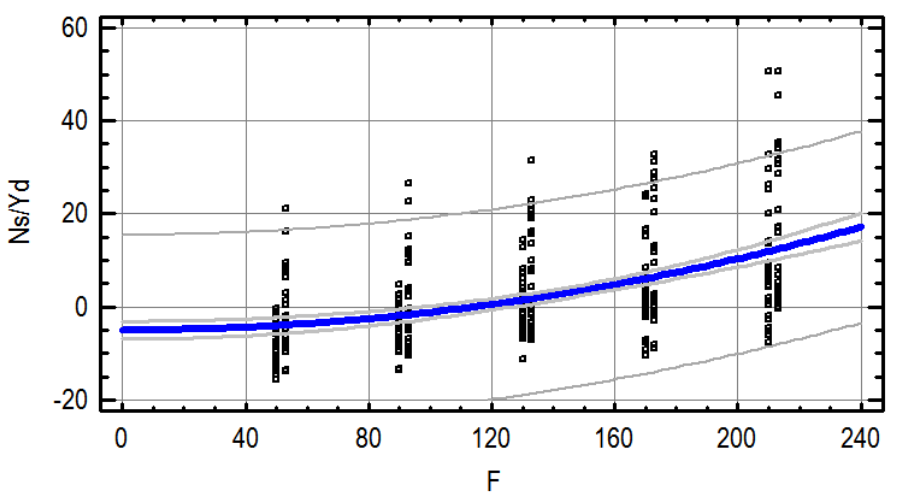
Figure 5. Observed and predicted yield-scaled N surplus (Ns/Yd, kg N·Mg − 1 ) depending on nitrogen doses (F, kg N·ha − 1 ) (R 2 = 23.9%, n = 320) . The relationship between N 2 O/Yd and N doses was described by the reciprocal-Y model: N 2 O/Yd = 1/(4.88 − 0.0138*F), R 2 = 47.0% (Figure 6). The estimated N 2 O/Yd values for the critical doses of F 112 and 149 kg N · ha − 1 were 0.30 and 0.35 kg N · ha − 1 , respectively. The curve increases steeply at higher N doses. At these doses, the spread of Ns/Yd around the regression curve also increased.